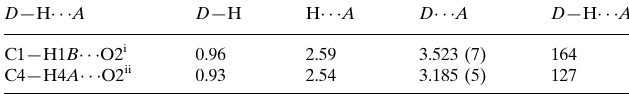
Hydrogen-bond geometry (A˚ , (cid:1)